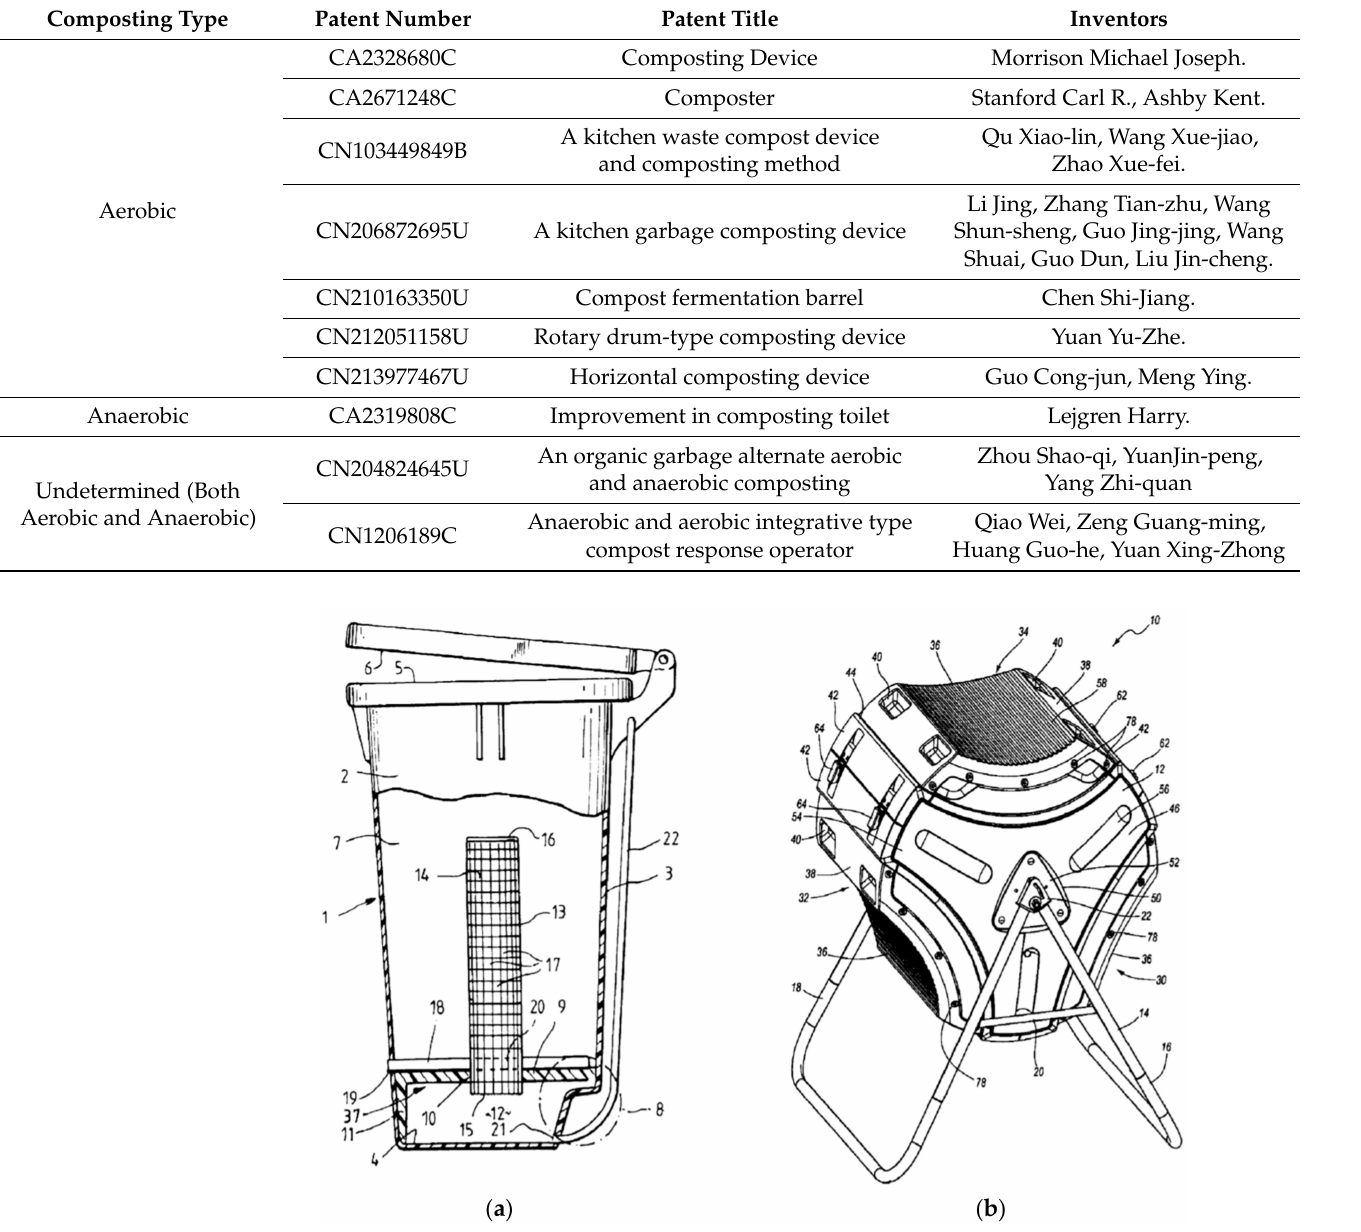
Figure 18. ( a ) An aerobic manual composter from CA2328680C [81], with details in Appendix A, Table A1; ( b ) an aerobic manual composter from CA2671248C [82], with details in Appendix A, Table